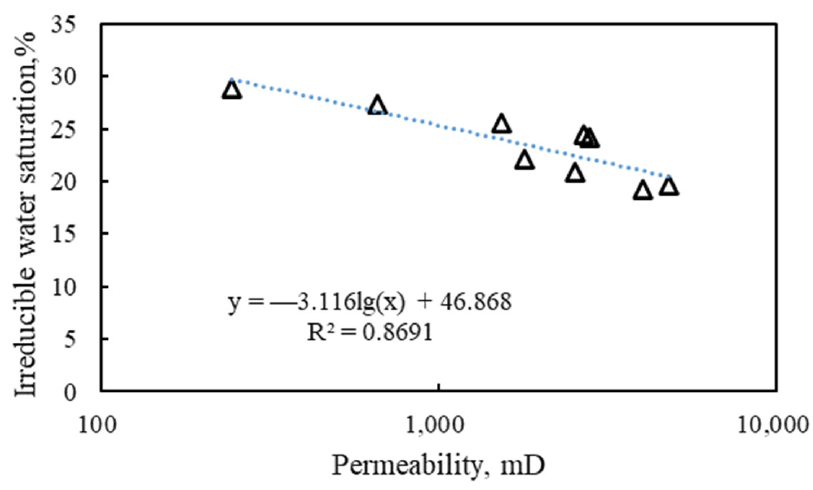
Figure 9. The relationship between the irreducible water saturation and permeability.